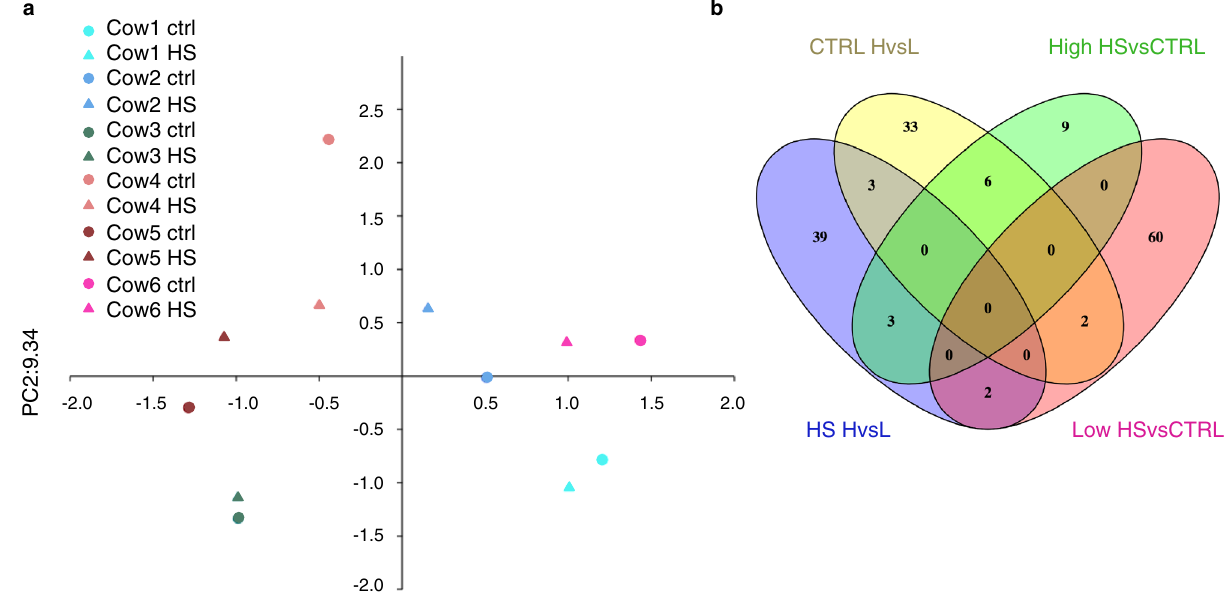
Figure 1. Effect of heat stress and immune response phenotype on DNA methylation in blood mononuclear cells from cows. ( a ) Principle component analysis showing overall methylation profiles across all samples. The first dimension explained 25.6% of variation. ( b ) Venn Diagram showing overlapping differentially methylated promoters from the four